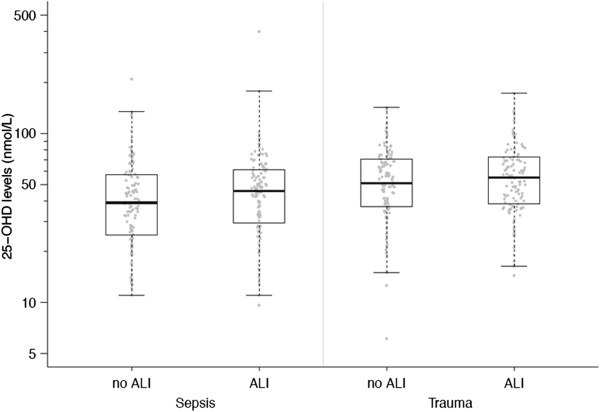
Box plot summary of 25-hydroxyvitamin D (25-OHD) levels by cohort and case-control status. Twenty-five-OHD levels were not significantly different between patients with or without acute lung injury/acute respiratory distress syndrome (ALI/ARDS). Horizontal bars represent medians, boxes encompass the 25th to 75th percentile and error bars encompass the 10th to 90th percentile.